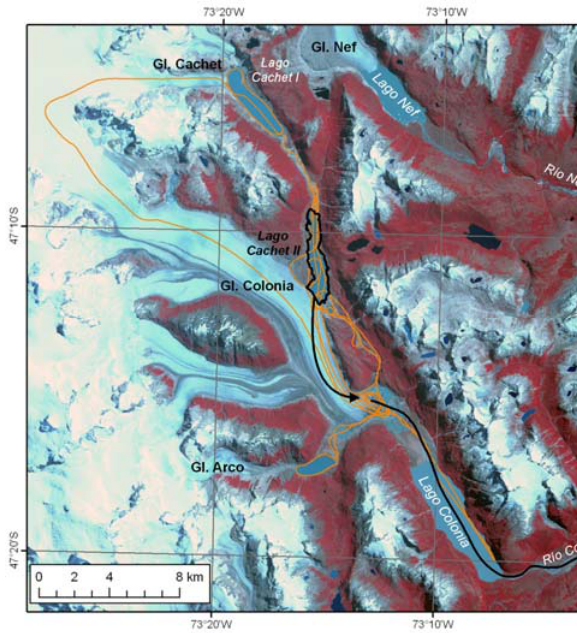
Figure 1: Satellite image of Lago Chachet II glacier lake drainage paths (in black) at Glaciar Colonia (Cassasa et al., 2009) The lake has a length of 5 km, a width of 1 km, a maximum depth of 100 m and a volume of ca. 200.000.000 m 3 . For Glaciar Colonia , a surface decrease of 9.1 km 2 (2.7% of the to- tal surface area) has been reported for 1979-2001 (Rivera et al., 2007); Masiokas et al. (2009) report a glacier front retreat by ca. 1 km; Casassa (2009) reports a thinning of the glacier tongue, which is about 2 m/a in the region of the Lago Cachet II contact.